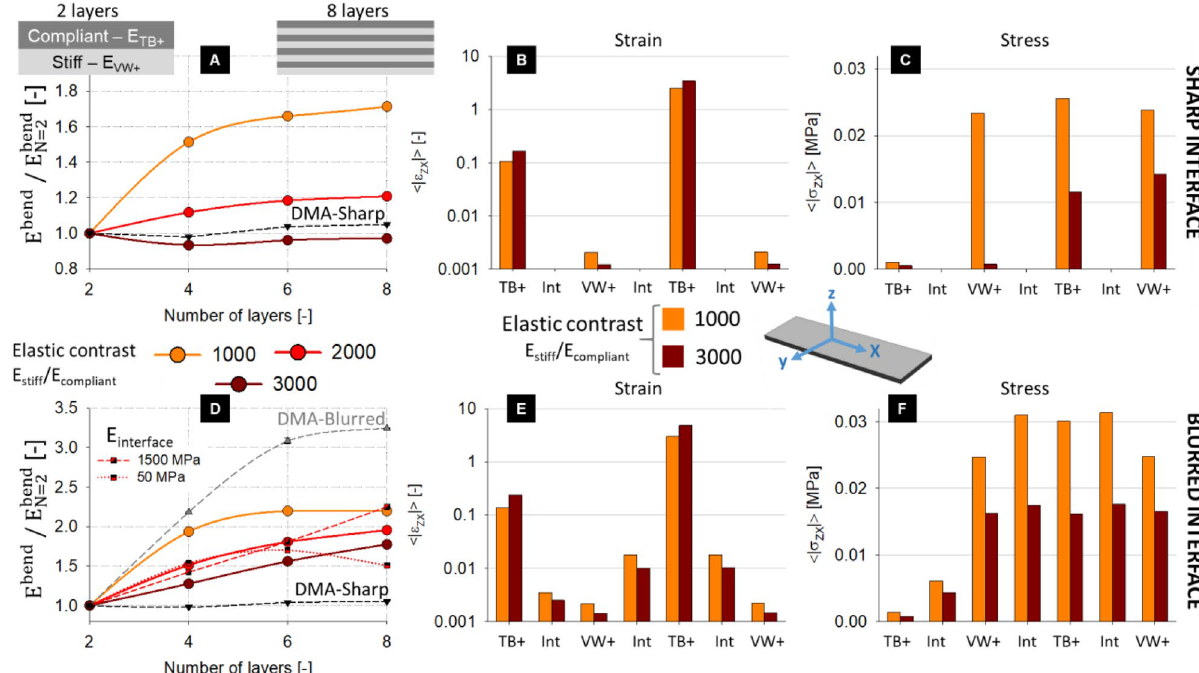
Figure 6. Results of the finite element simulations for the virtual composites with layers stacked along the thickness. ( A ) Apparent bending modulus (calculated with Eq. 4 and normalized by the apparent modulus of the two-layer configuration) for different elastic contrasts between compliant and stiff layers (E stiff / E compliant = 1000, 2000 and 3000). In this situation, there was an ideal zero-thickness interface between layers. The experimental behavior obtained by DMA for the sharp interface is also shown. ( B ) Average shear strain and ( C ) shear stress computed within all the alternating layers (for the 4-layer scenario) without interface and assuming two different elastic contrasts (E stiff /E compliant = 1000 and 3000). ( D ) Normalized apparent bending modulus assuming a blurred interface between alternating layers (thickness of 150 μm and elastic modulus of 500 MPa). For an elastic contrast of 2000, two additional elastic properties for the interface were considered: 50 and 1500 MPa. Experimental DMA data are shown for both the blurred and sharp interface. ( E ) Average shear strain and ( F ) shear stress computed within all the alternating layers assuming a finite size interlayer interface (thickness 150 μm, elastic modulus 500